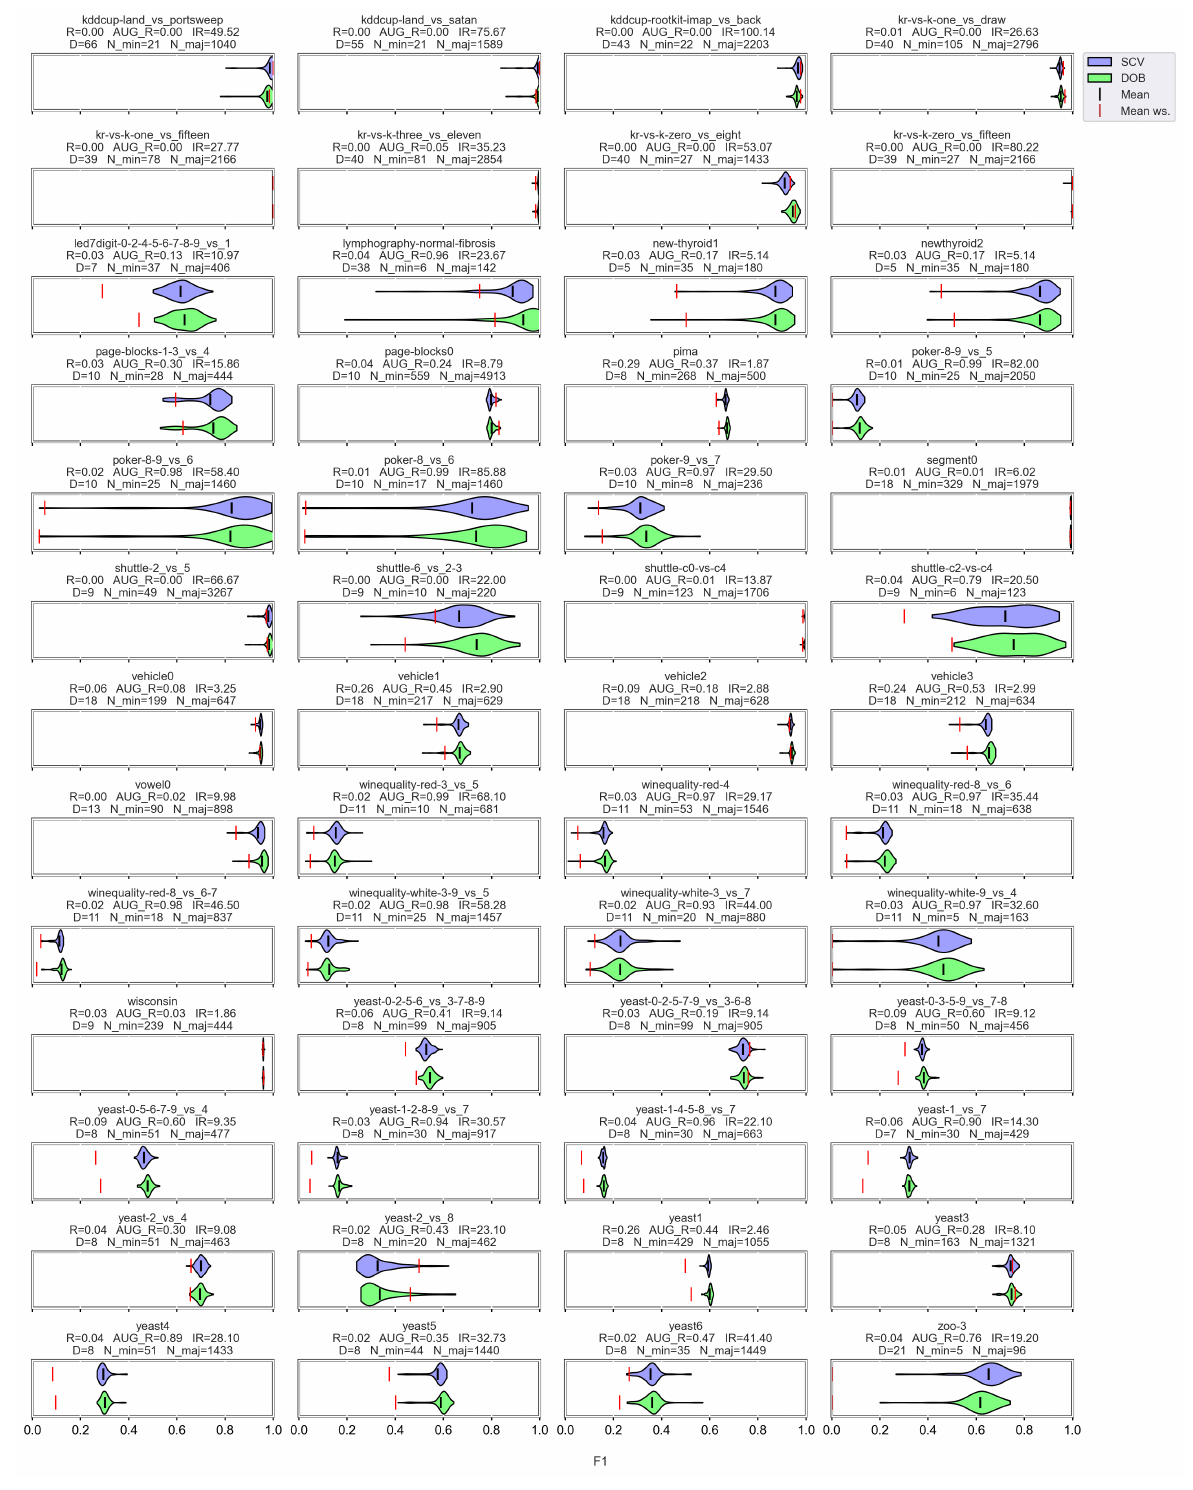
Figure A3. F 1 values resulted by the MLP classifier and the named oversamplers per data set of